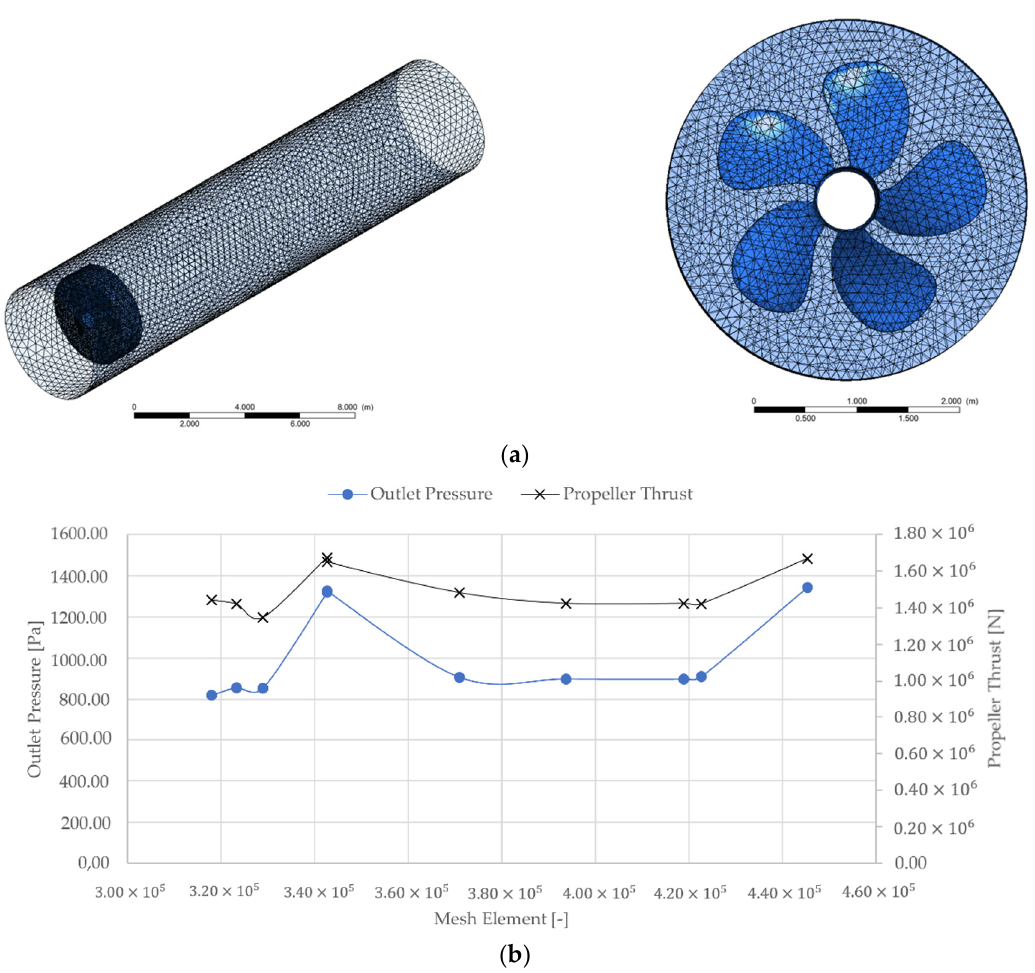
Figure 3. ( a ) Tetrahedron grid distributions on the computational domain; ( b ) mesh sensitivity study.